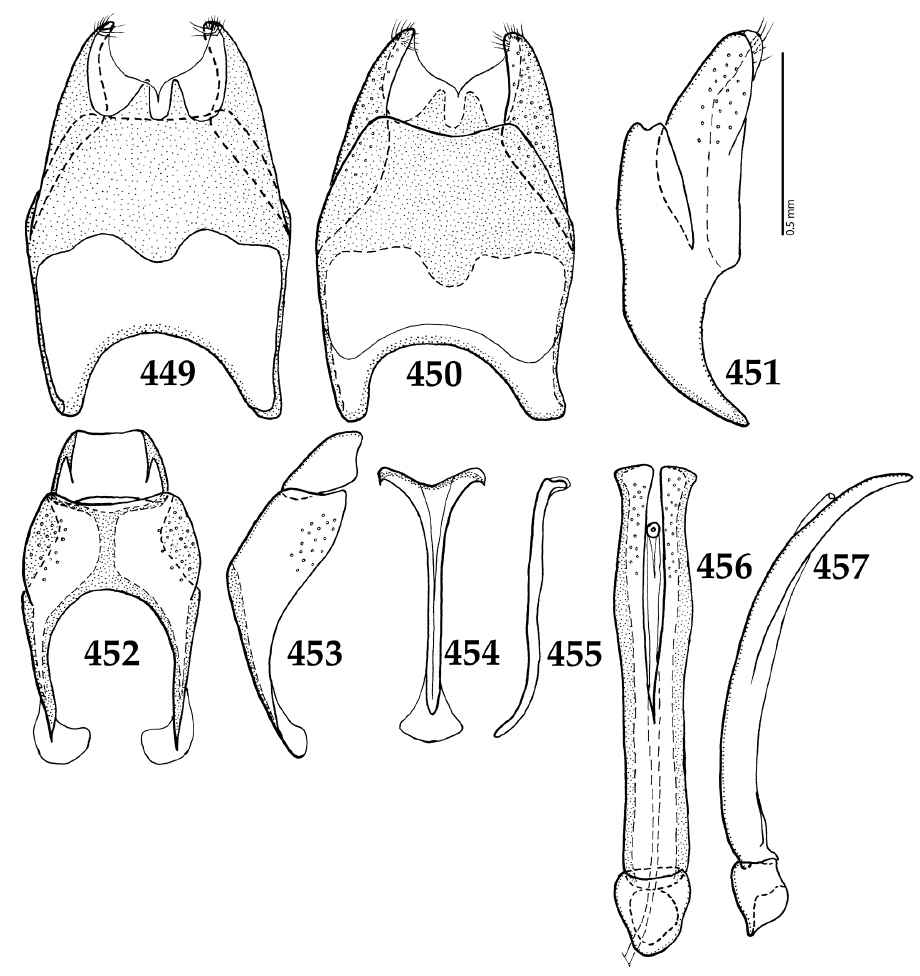
Figures 449–457. 449 Saprinus ( Saprinus ) grandiclava Kanaar, 1989 male terminalia: 8 th sternite + 8 th tergite, ventral view 450 ditto, dorsal view 451 ditto, lateral view 452 male terminalia: 9 th + 10 th tergites, dorsal view 453 ditto, lateral view 454 male terminalia: spiculum gastrale, ventral view 455 ditto, lateral view 456 male terminalia: aedeagus, dorsal view 457 ditto, lateral